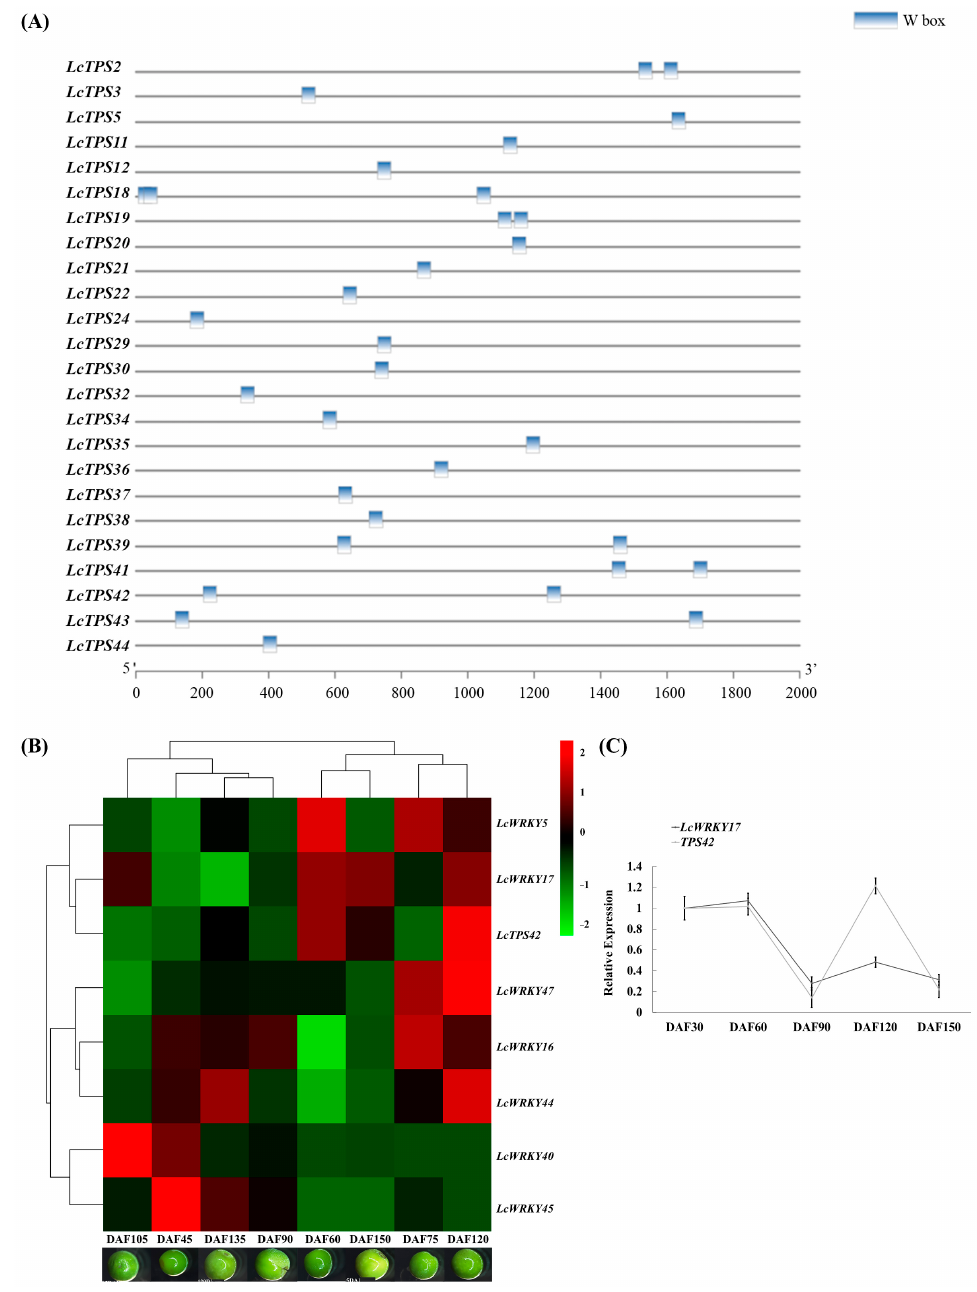
Figure 3. ( A ) Analysis of TPS (terpene synthases) promoter cis-acting elements in L. cubeba . ( B ) Cluster analysis of hub genes and TPS42. ( C ) Gene expression of LcWRKY17 and LcTPS42 in different developmental stages of the fruit (day after flower, DAF). UBC gene is the internal reference, the expression value of the first sample DAF30 is set to 1, and the data are represented as the mean. The error bars represent the standard deviation of three biological repeats. Based on Student’s t -test, asterisks indicate statistically significant differences from sample 1